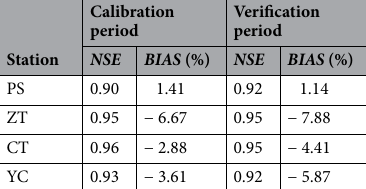
Table 4. Simulation performance of monthly mean runoff during the calibration and validation